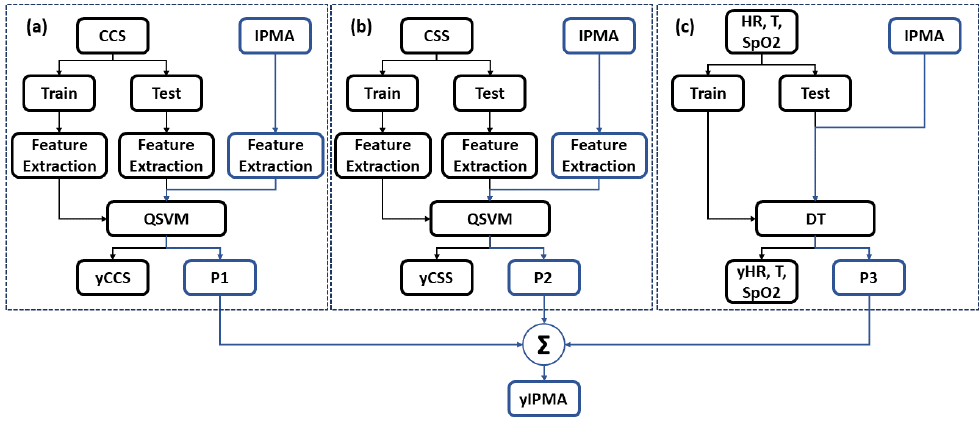
Figure 8. Block diagram of the machine learning algorithms used in this study. ( a ) Cough signal; ( b ) speech signal; ( c ) heart rate, body temperature, and SpO2.